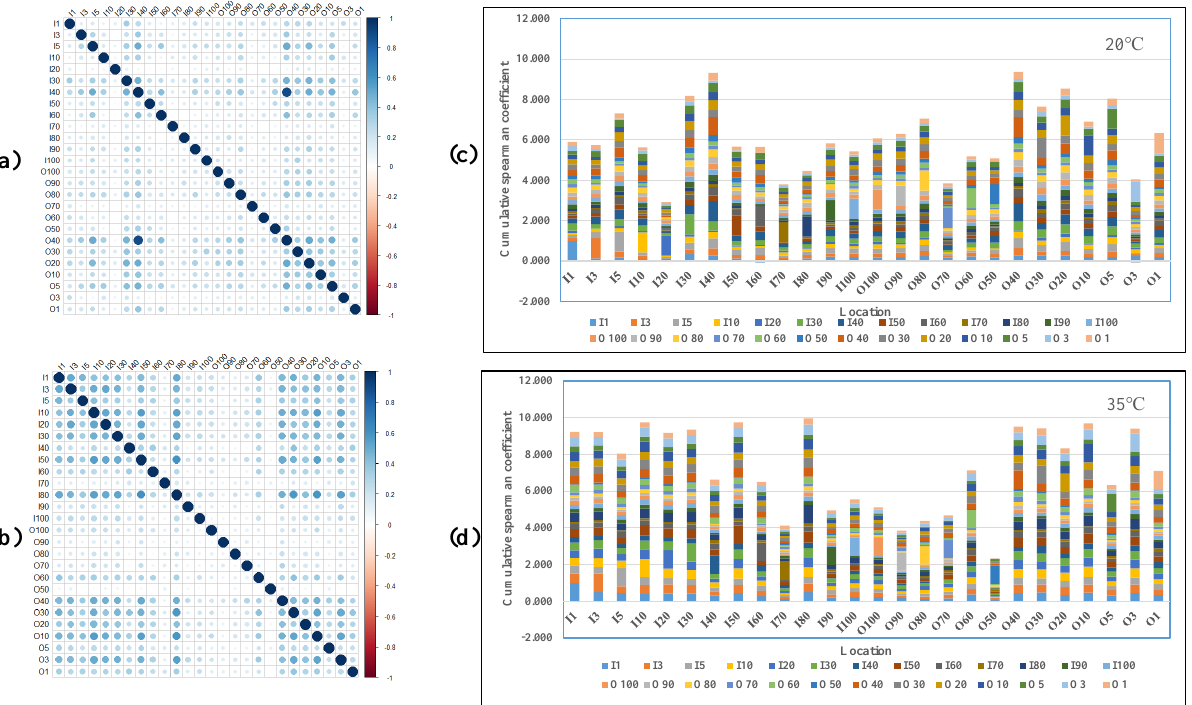
Figure 5. Spearman coefficient of content difference during initial solidification of CC billets. ( a ) Heat map of Spearman coefficient between different locations under 20 ◦ C superheat. ( b ) Heat map of Spearman coefficient between different locations under 35 ◦ C superheat. ( c ) Cumulative Spearman coefficient at each location under 20 ◦ C superheat. ( d ) Cumulative Spearman coefficient at each location under 35 ◦ C